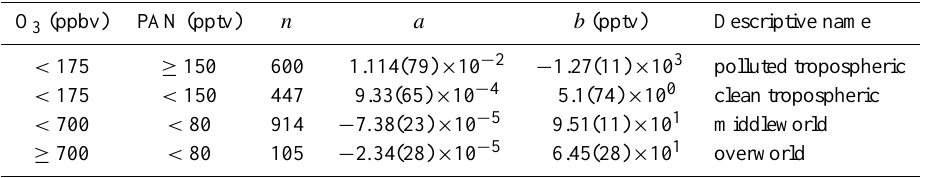
Table 2. Correlation between O 3 and PAN for different air masses. The selection criteria are listed in the first two columns. The third column gives the number of n samples matching the selection criteria. An orthogonal distance regression fits the formula of PAN ( pptv ) = a · O 3 ( pptv ) + b (pptv). Columns four and five give a and b with the number in brackets being the standard deviation for the last two digits.